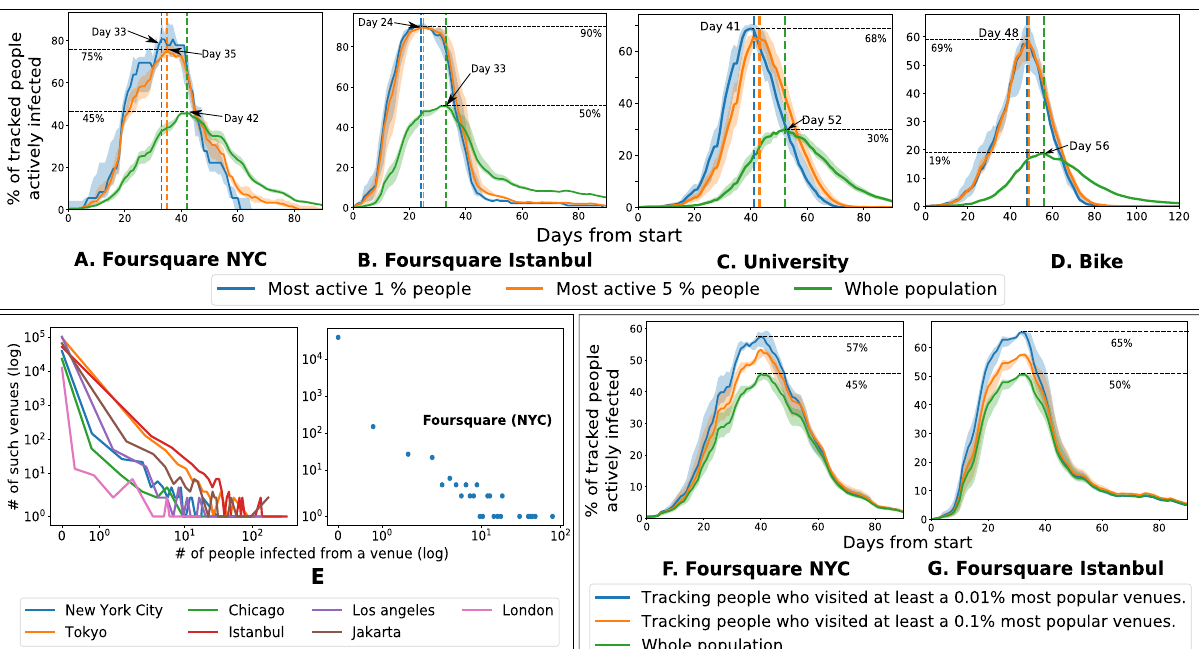
Figure 3. Heterogeneity of mobility in venues and agents results in varied risks to catch and spread the virus. Agents with higher activity get infected with a higher proportion and earlier ( A – D ). In all Foursquare